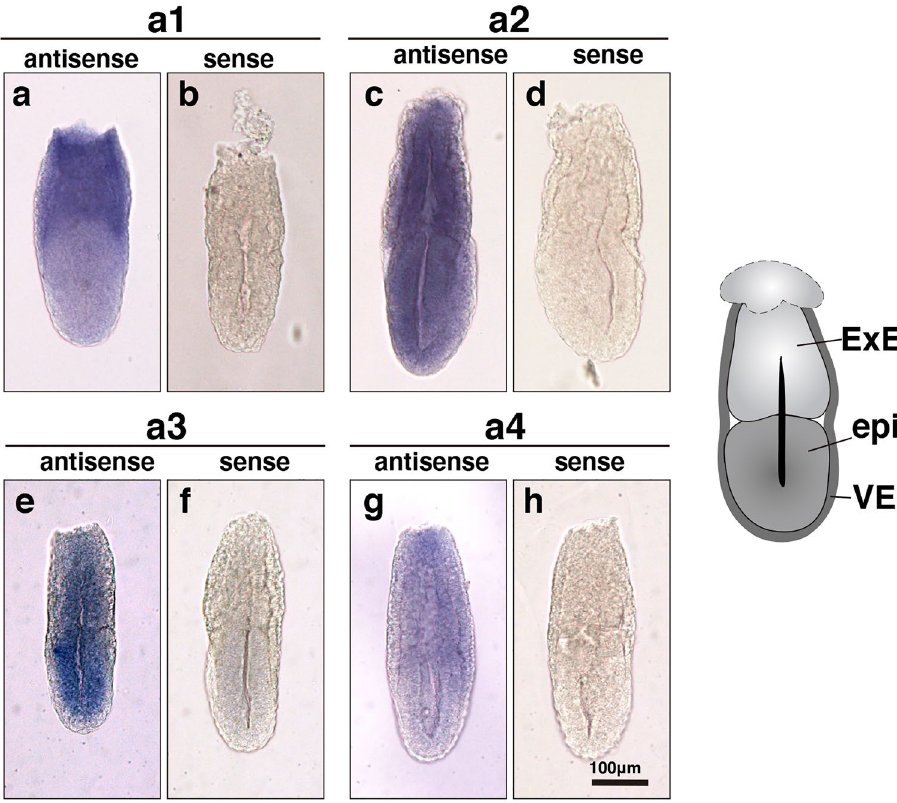
Figure 1. Whole-mount in situ hybridization analysis of a subunit isoform expression in mouse E6.5 embryos. Whole-mount in situ hybridization assays for a1, a2, a3, and a4 mRNA were carried out with anti-sense ( a , c , e , g ) or control sense ( b , d , f , h ) probes using E 6.5 mouse embryos. All assays were performed using at least three embryos. Specific labelling was observed with anti-sense probes, and no specific staining above background was observed with the negative control probes. An illustration of the E6.5 embryo is shown on the right. VE, visceral endoderm; ExE, extraembryonic ectoderm; epi, epiblast. Scale bar, 100